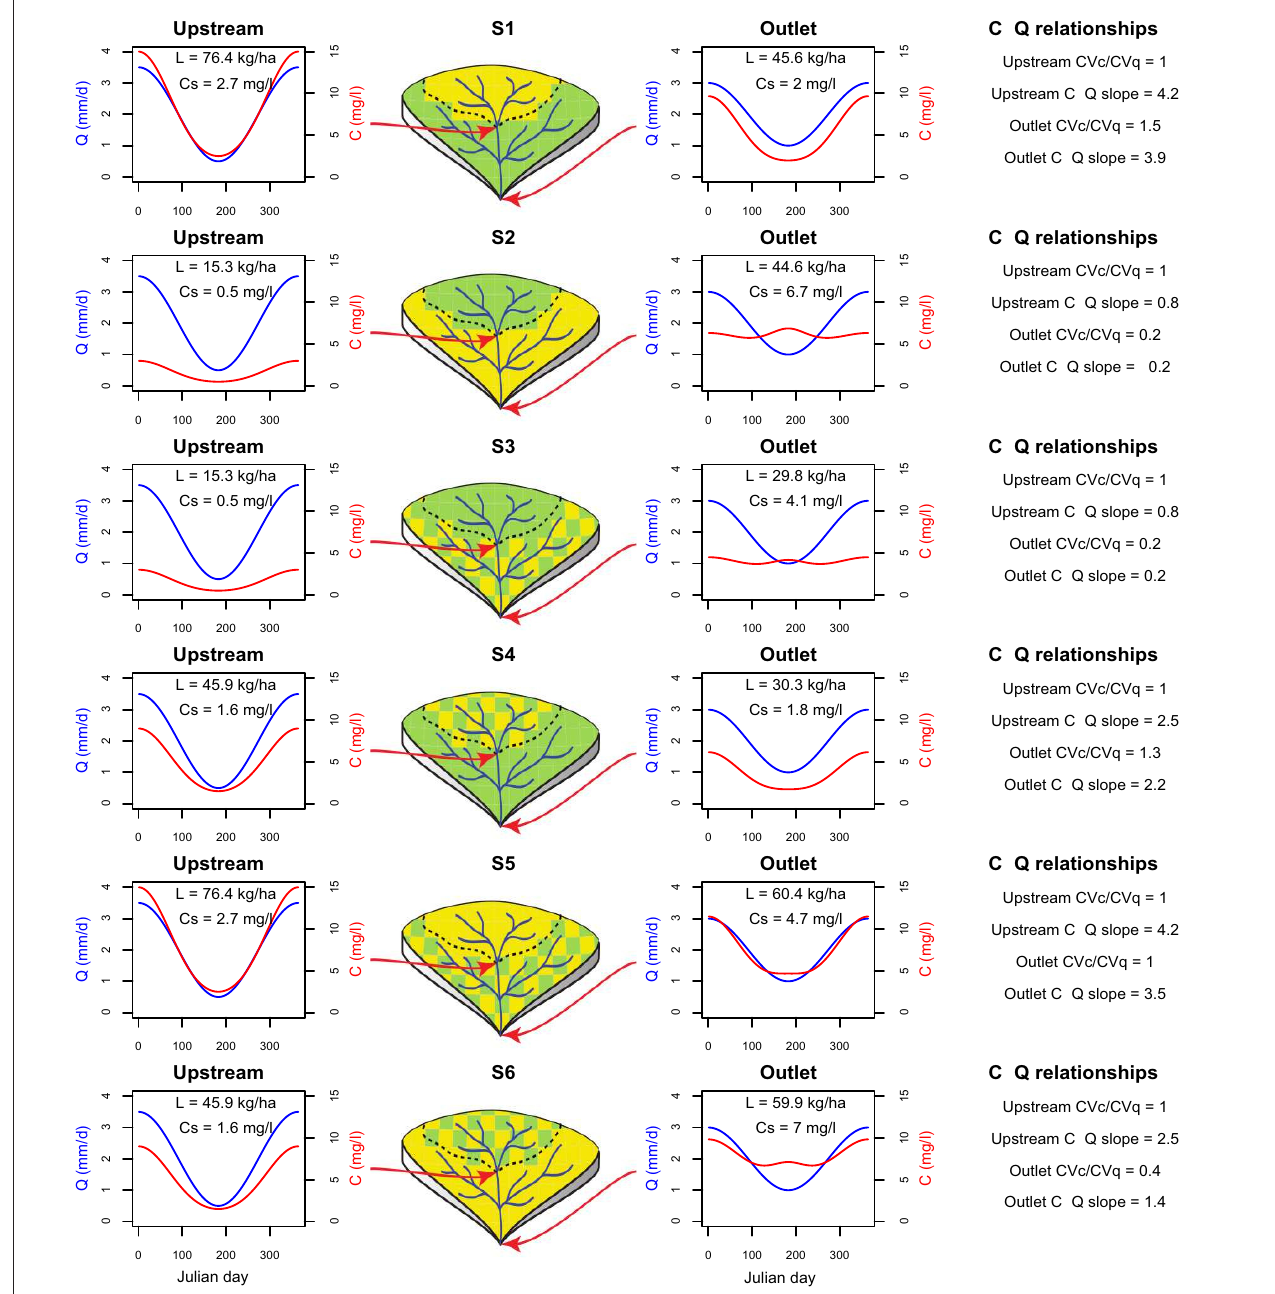
FIGURE 2 | Nutrient concentration dynamics resulting from six landscape unit distribution (LUD) scenarios. Each scenario is evaluated for its capacity to reach two water quality targets: annual load (L) and summer concentration (Cs) in upstream reaches and at the outlet. The water quality metrics CVc/CVq (ratio of the coefficient of variation of concentration and discharge) and C-Q slope (slope of the concentration-discharge relationship) are also estimated at the upstream reaches and the